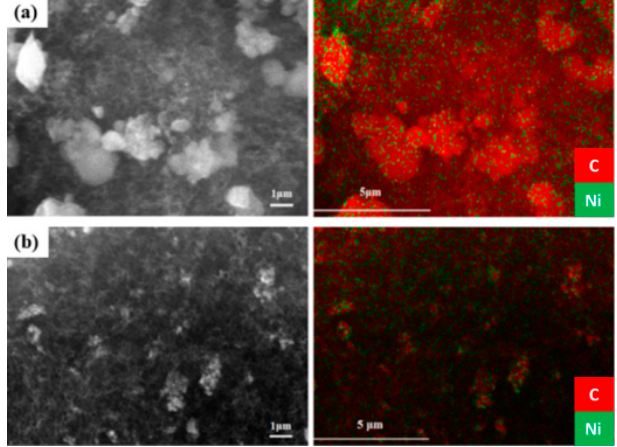
Figure 11. SEM images and carbon EDX images of the spent catalysts: ( a ) Ni/Al 2 O 3 , and ( b ) Ni/AlCeO 3 (samples tested under experimental protocol #2).